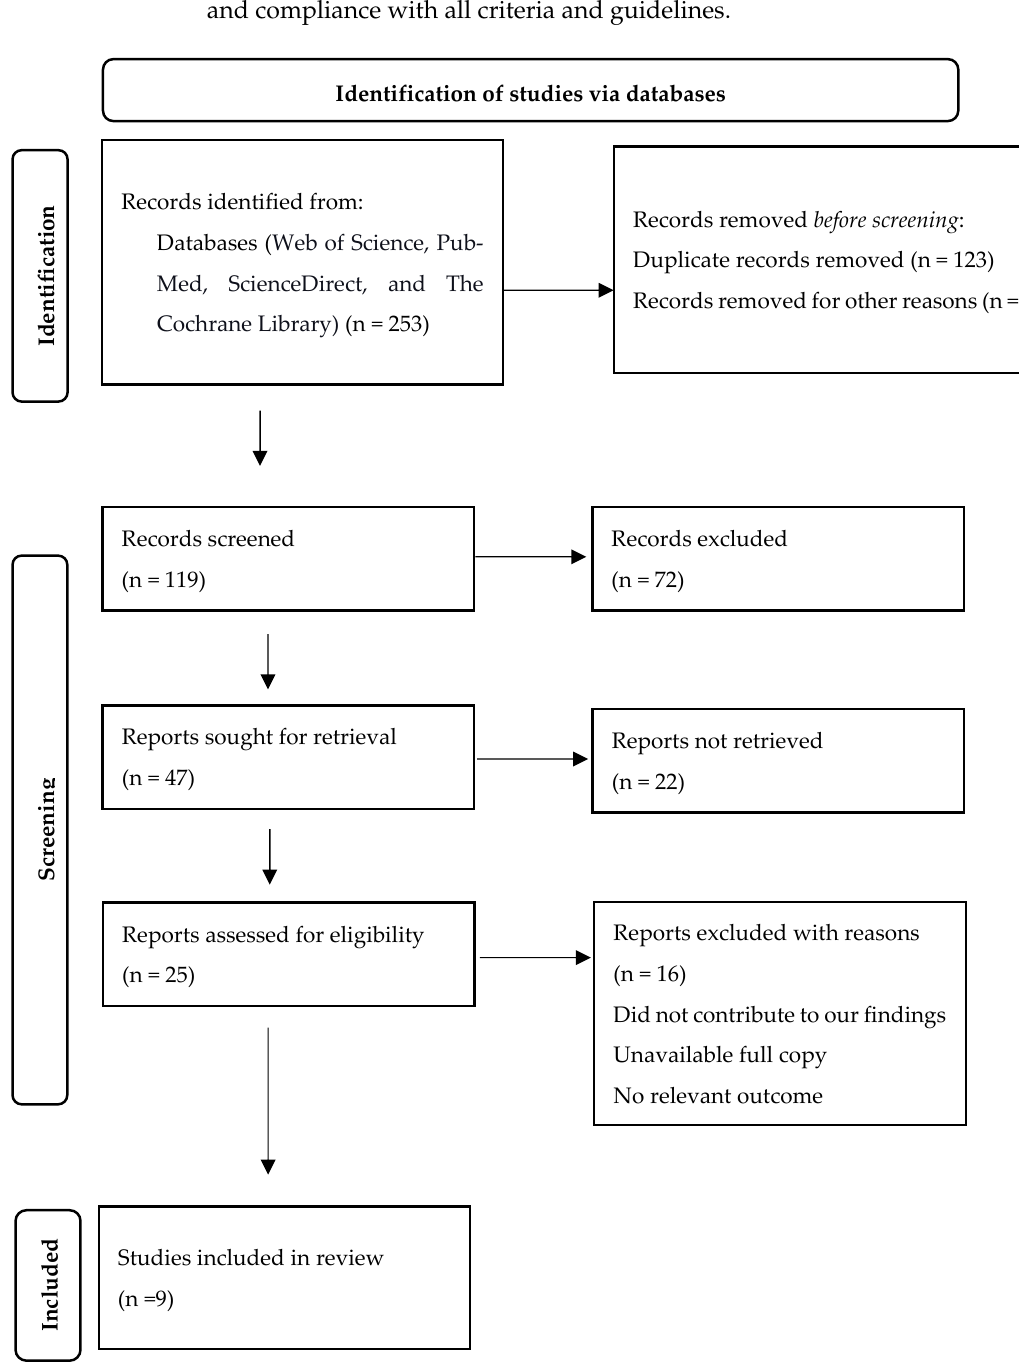
Figure 1. Flow diagram for the selection of studies included in a systematic review of physical activity counseling in KSA.